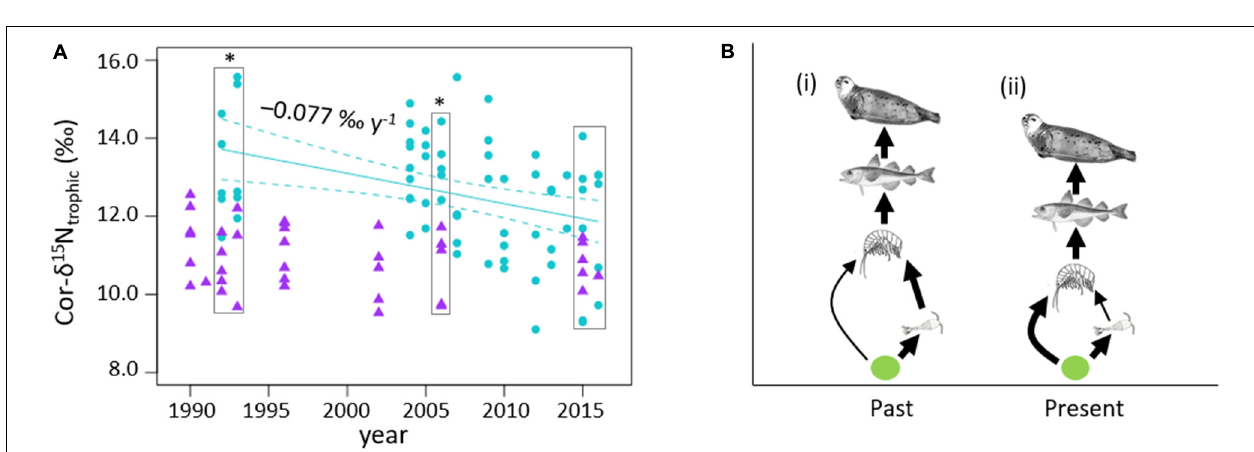
) per year in ringed seals muscle from the CAA (turquoise circles) and Baffin Island FIGURE 4 | (A) Baseline-corrected δ 15 N trophic values (Cor- δ 15 N trophic ) in per mil ( (purple triangles); The slope of significant linear models (solid lines; p < 0.01, Table 2 ) and 95% confidence interval (dashed lines) are shown on the graphs; the (cid:104) boxes indicate the years when the Cor- δ 15 N trophic values were compared between the Baffin Island and the CAA, * indicates significant differences between the Southern Baffin Bay and the CAA; (B) proposed food web structure in time explaining the shortening of the food chain in the CAA (i) high omnivory in the zooplankton community and (ii) high herbivory in the zooplankton community, modified after McMeans et al.